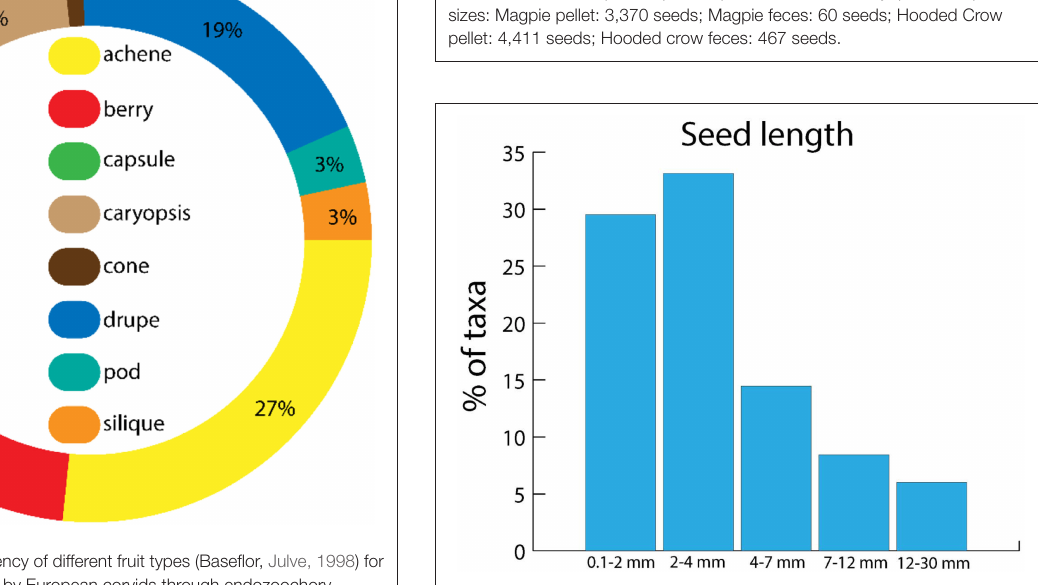
FIGURE 5 | Seed length distribution for all the plant taxa dispersed by European corvids through endozoochory, according to Heintze’s complete list ( n = 143 taxa, 14 species were excluded because their seed length was unknown, see Table S1 ).